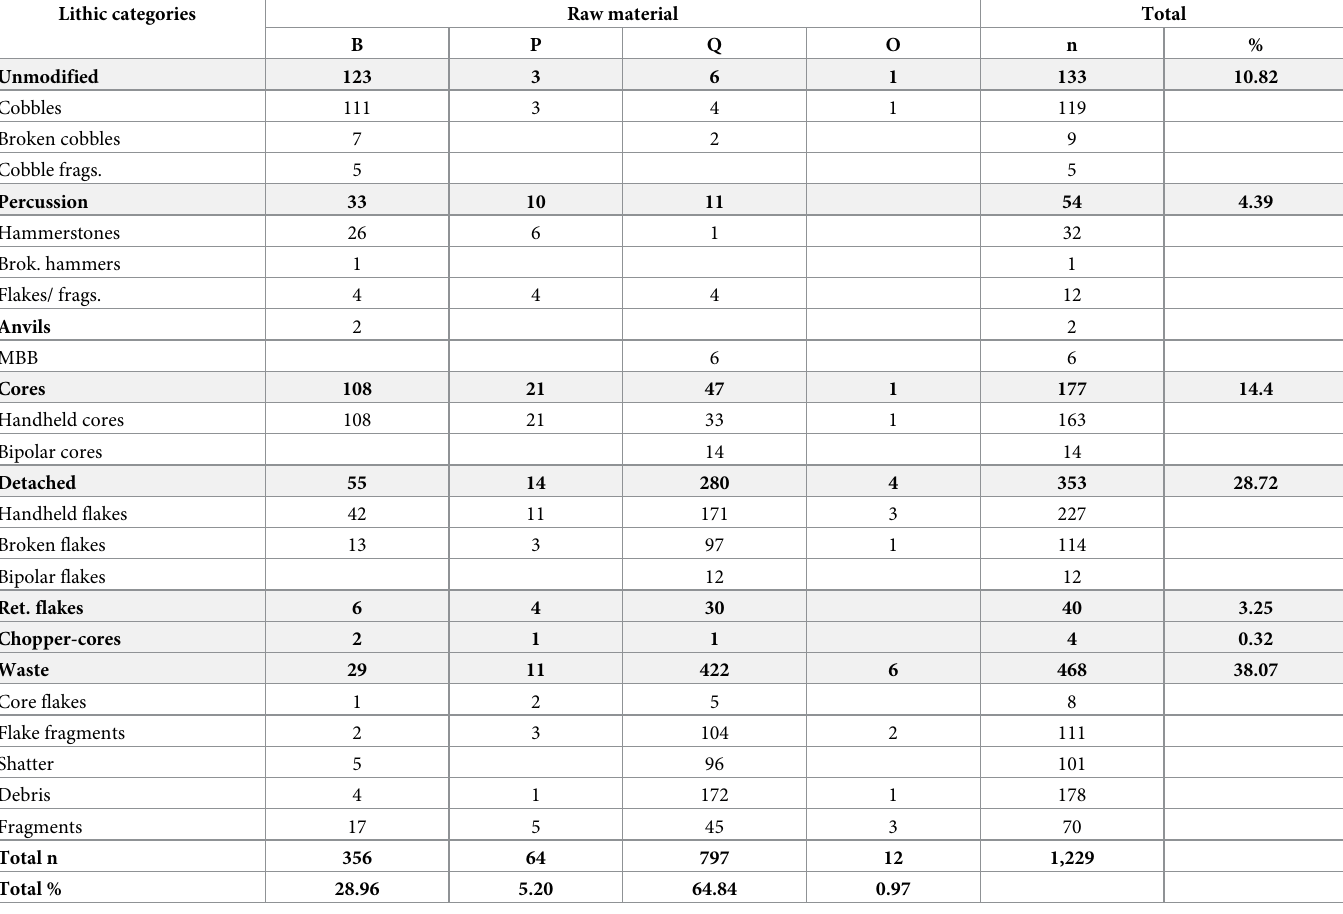
Table 1. Number and percentage of lithic artefacts sorted by lithic category and raw material